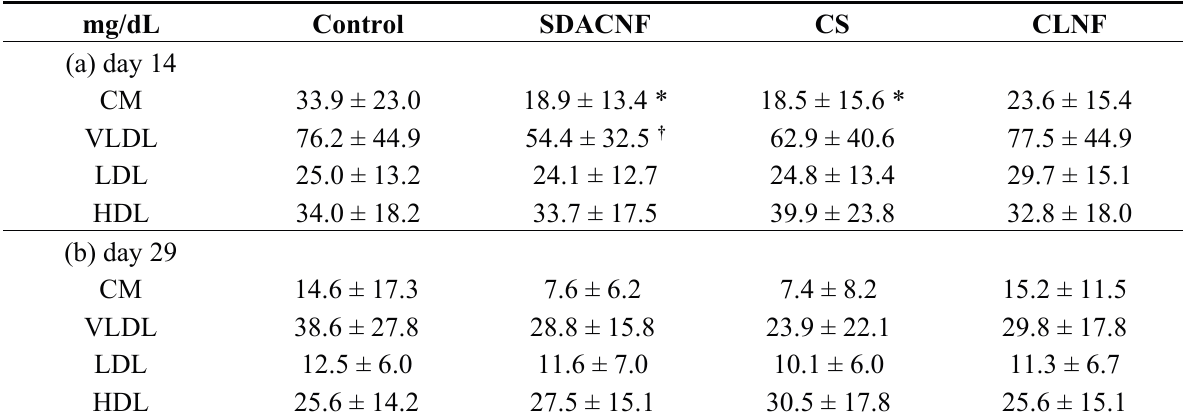
Table 4. Effects of oral administration of SDACNFs on serum T-Cho contents. Each table summarizes serum T-Cho contents on day 14 ( a ) and day 29 ( b ). Data are presented as mean ± standard error. *: p < 0.05 compared with the control group. † : p < 0.05 compared with the control and CLNF groups. dL: deciliter.